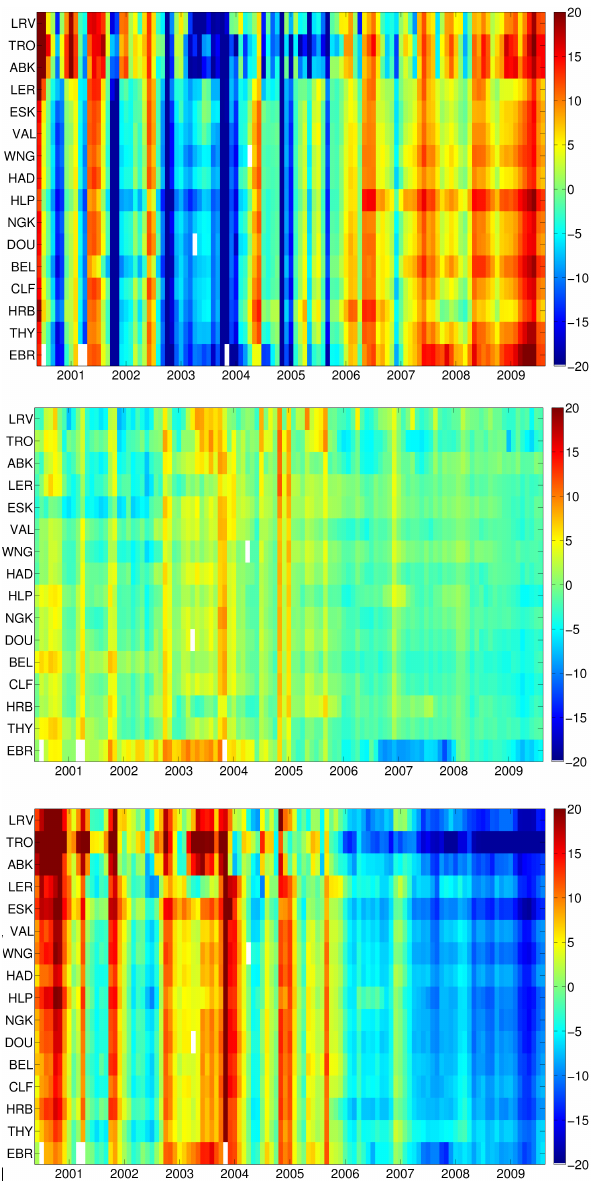
Figure 2. Variations around the X , Y and Z average monthly bi- ases of the European observatories over 9 years, from June 2000 to August 2009, in nanoteslas. The observatories ( y axes) are ordered by geomagnetic coordinates (the northernmost one at the top). The magnetic field components are expressed in geodetic